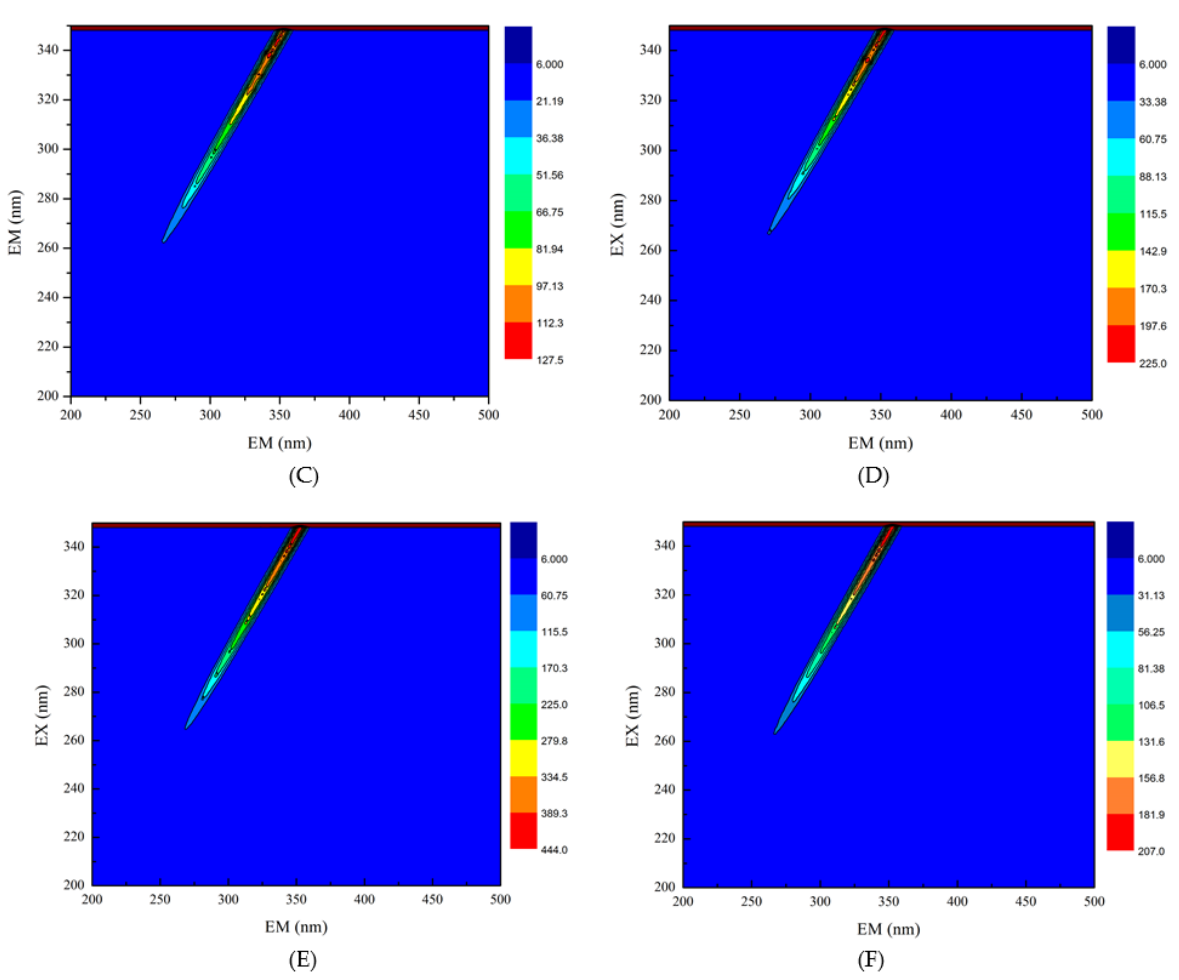
Figure 3. Three-dimensional fluorescence spectra of HPI and covalent HPI-EGCG complexes. ( A ) HPI, ( B ) HPI-1 Mm EGCG, ( C ) HPI-2 mM EGCG, ( D ) HPI-3 mM EGCG, ( E ) HPI-4 mM EGCG, and ( F ) HPI-5 mM EGCG, all suspended in H 2 O (Ex is the excitation wavelength and Em is the emission wavelength).